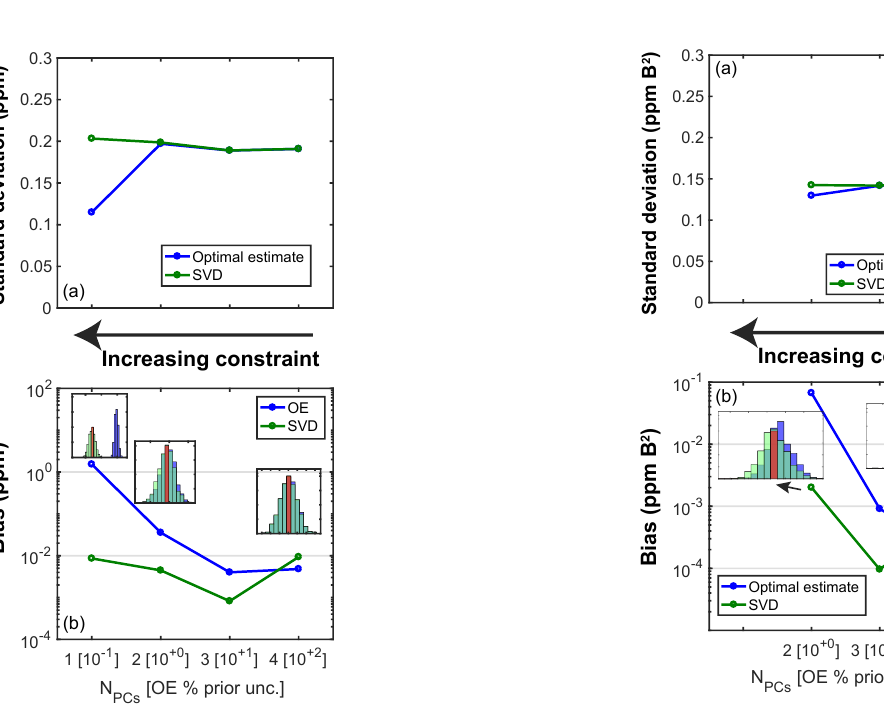
Figure 11. Robust measurement of the CO 2 vertical dipole moment Figure 10. Robust measurement of the X CO column mean by the 2 by the SVD method. As in Fig. 10, we look at the variance (a) and SVD method. Results from ensembles of 1000 numerical experi- bias (b) in the retrieved CO 2 vertical dipole moment for ensem- ments show that for retrievals using the SVD method for a range of bles of 1000 numerical experiments at varying constraints. As with constraints (one to four principal components), the variance (a) and the column X CO , the SVD results are robust and unaffected by the bias (b) in the column mean X CO are robust. In contrast, a similar 2 2 changing number (two to four) of principal components. In contrast, change in constraint when using the OE retrievals (changing prior the OE results incur a significant bias (0.1ppmB 2 ) when the prior uncertainty in the layer CO 2 mixing ratio from 100% to 0.1%) pro- uncertainty (the regularizing constraint) for the CO 2 mixing ratio at duces a decrease in the variance of X CO , but also a sharp increase 2 each layer is set at 1%. Insets in the lower plot illustrate the ensem- in bias, above the 0.5ppm accuracy needed for reasonable CO 2 flux ble distributions at the minimum and maximum constraints as done inversions. Insets in the lower plot illustrate the ensemble distribu- in Fig. 8 (left tions at different constraint points as done in Fig. 8 (center and right plots).